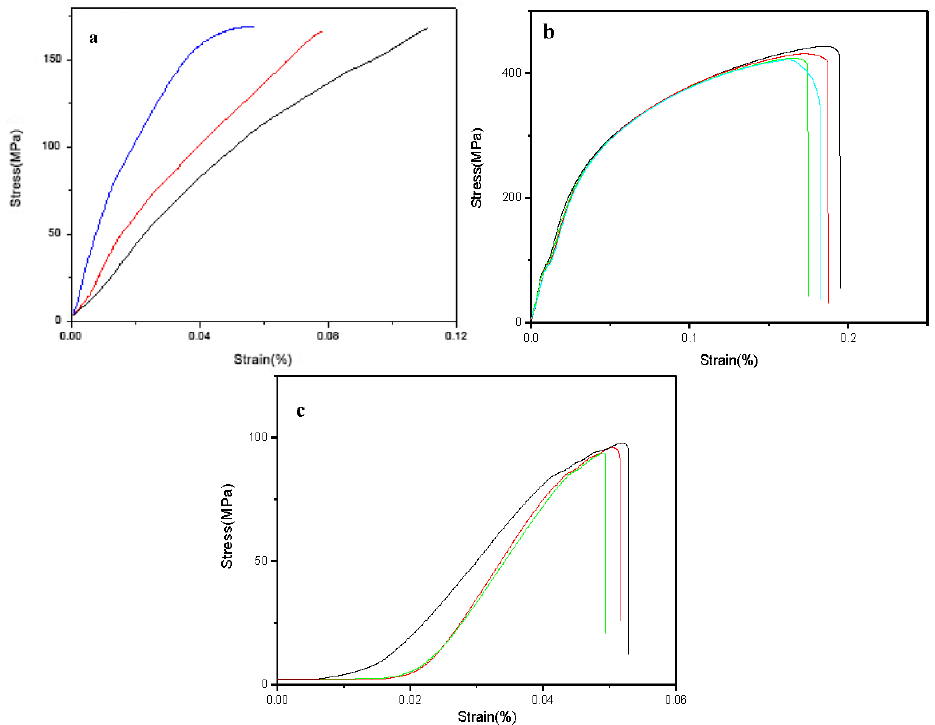
Figure 6. Stress-strain curves of Cu/Ti 3 SiC 2 /C/BN/GNPs nanocomposites for: ( a ) tensile tests; ( b ) compressive tests; and ( c ) shear tests. (Red, green, and black lines represent three measured results of the specimen for three times)